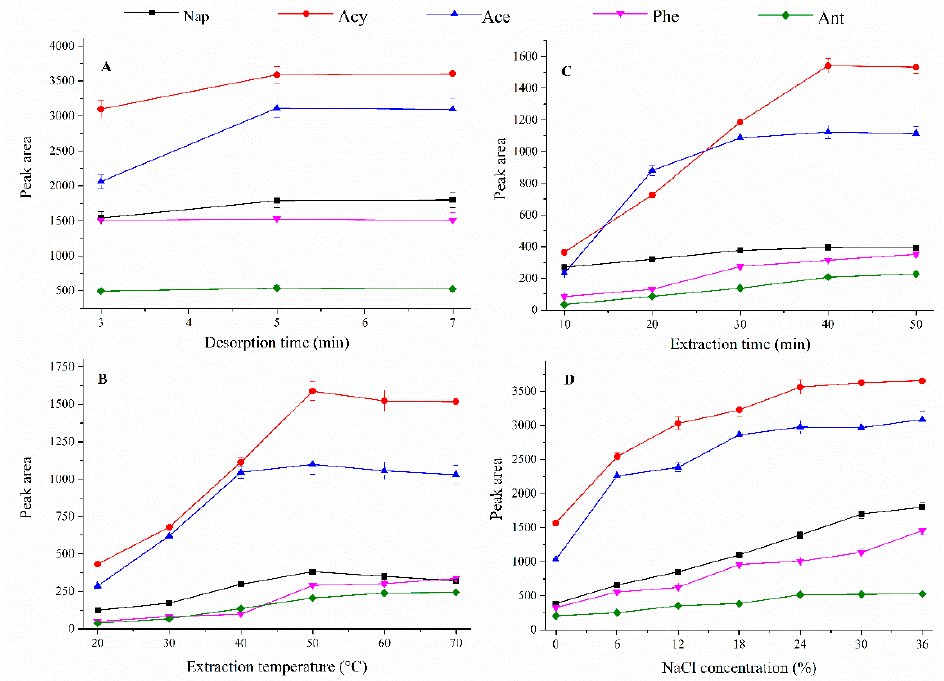
Figure 4. The optimization profiles of ( A ) desorption time; ( B ) extraction temperature; ( C ) extraction time; and ( D ) NaCl concentration.